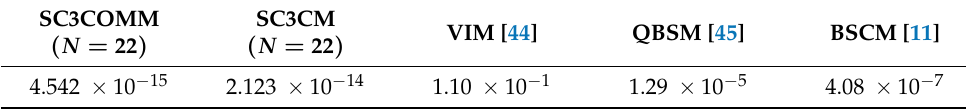
Table 2. Comparison between different methods of Example